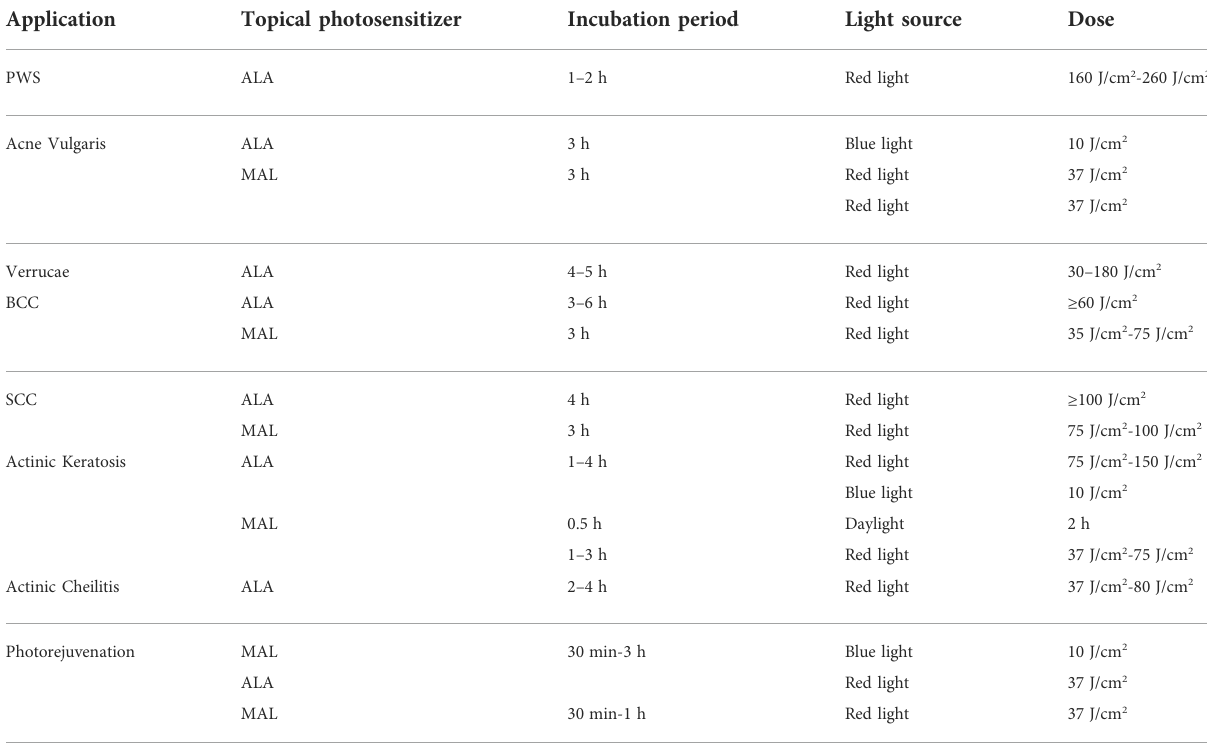
TABLE 2 Photodynamic therapy speci fi c treatment protocols for most common applications in the fi eld of plastic and reconstructive surgery.